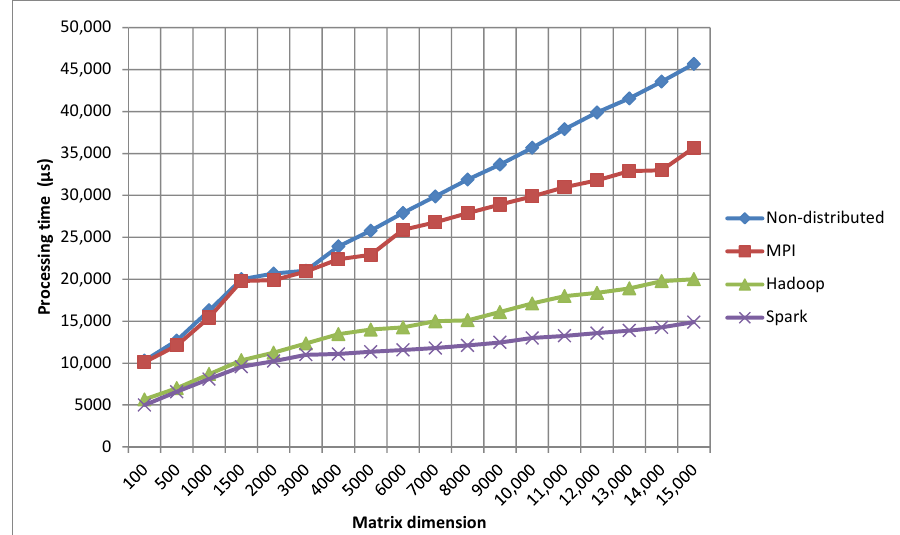
Figure 16. Dependence of the processing time of recommendations to users for large volumes on the dimensionality of the input data for the unmodified SVD method (1); a modified method based on MPI technology (2); a modified method based on Hadoop technology (3); a modified method based on Spark technology (4).